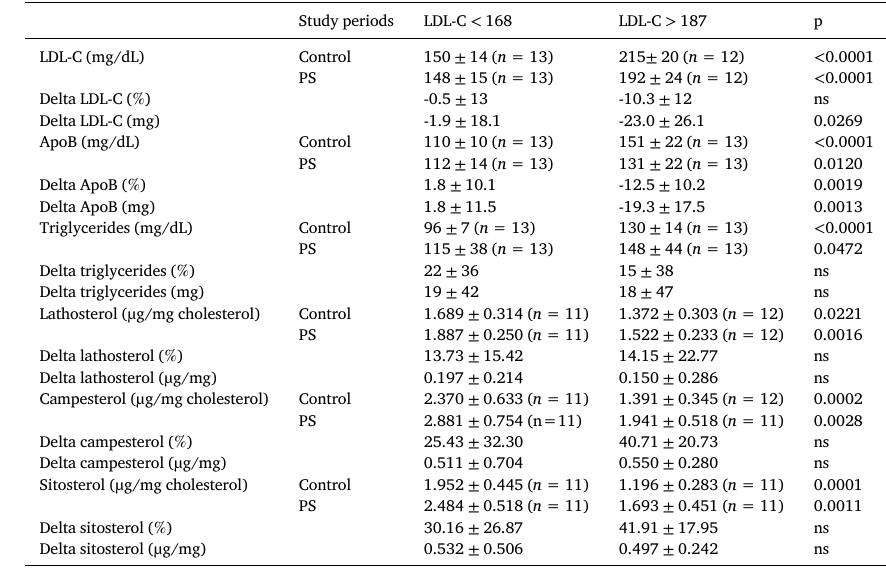
Table 4 Patients ' data during study periods according to the averages of LDL-C tertiles selected at baseline ( < 168 mg/ dL and > 187 mg/dL).